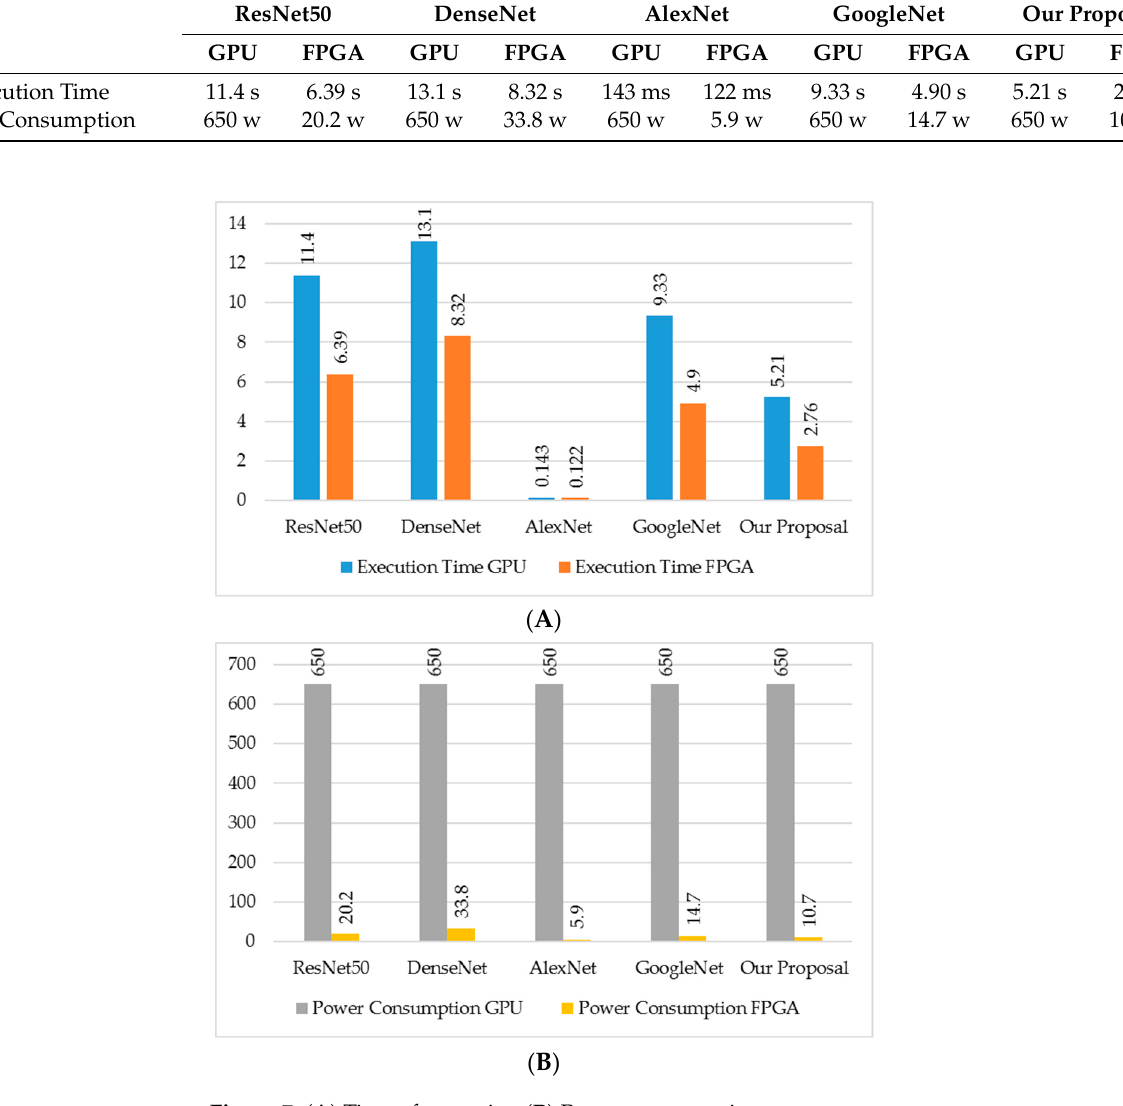
Figure 7. ( A ) Time of execution ( B ) Power consumption. Table 4. Overview of resources for DE1-Soc.